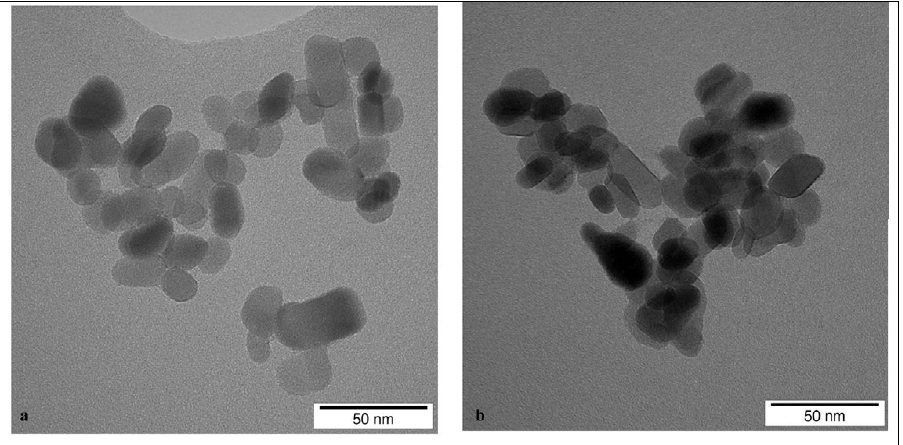
Fig. 5. TEM images of the as-prepared Cr 2 O 3 nanoparticles at a) 500 ºC and b) 600 ºC